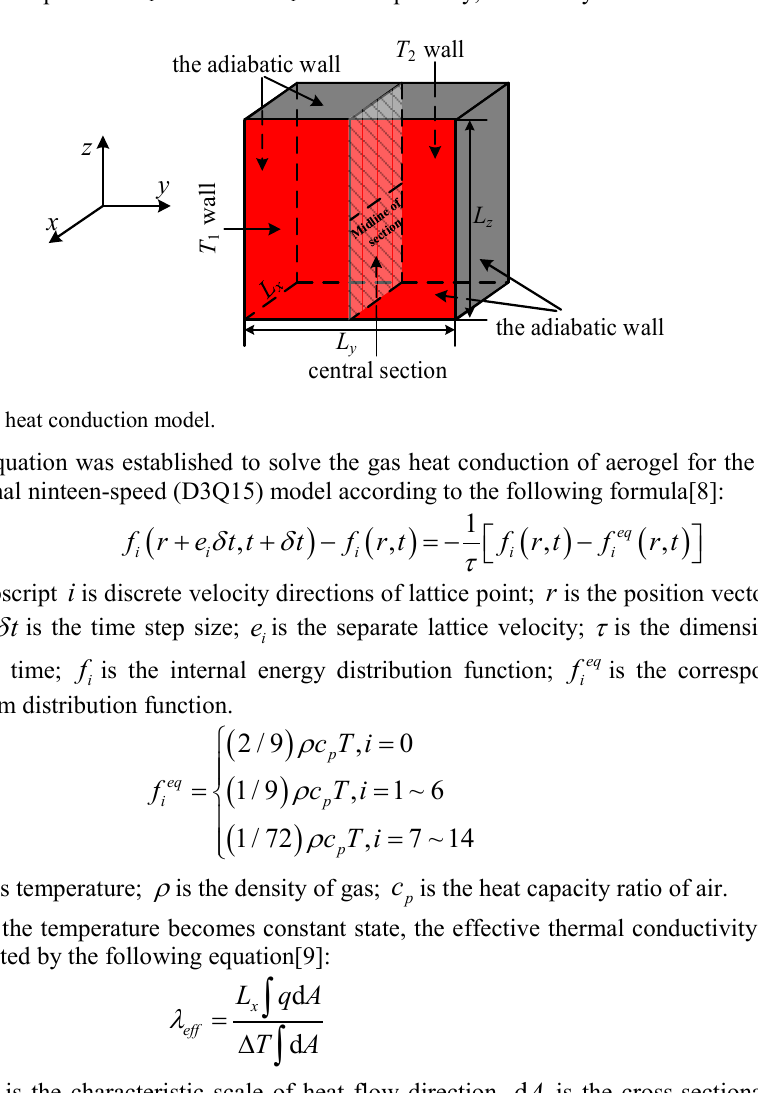
Fig.1 displayed the gas heat conduction model of aerogels. The length, width and height of the model were expressed as L x , L y and L z separately. The front and back walls are kept at a constant temperature T 1 =300K and T 1 =301K separately, others stayed adiabatic.